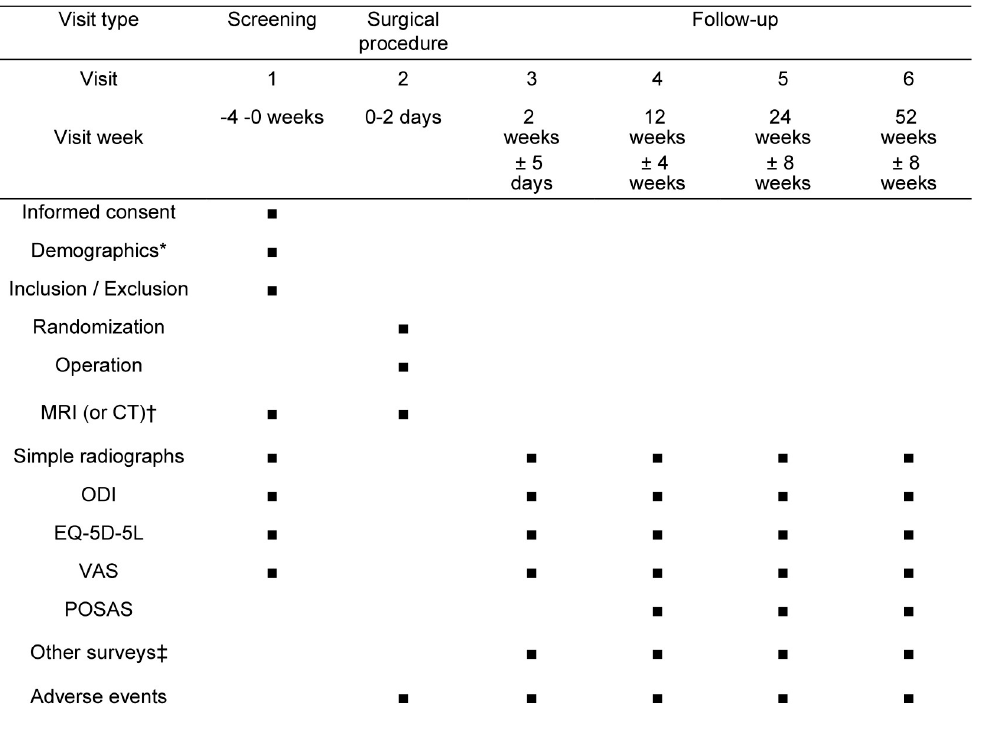
PLOS ONE | https://doi.org/10.1371/journal.pone.0283924 April 5,